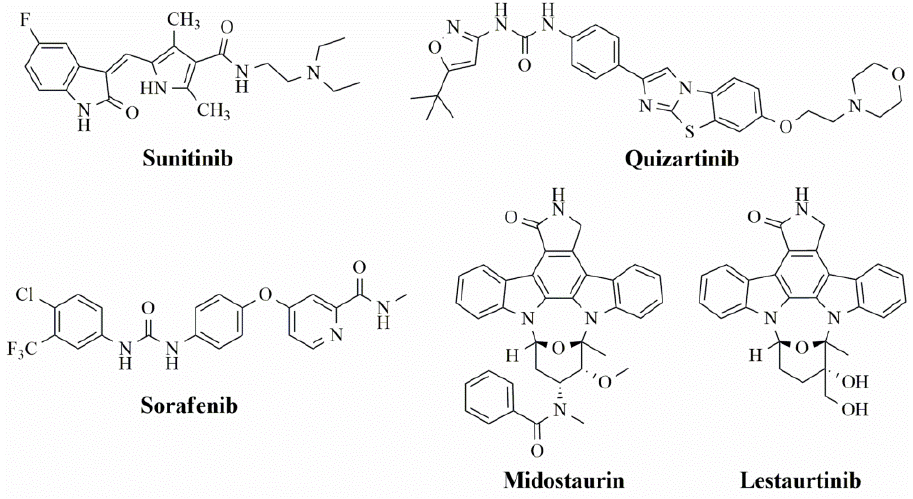
Figure 1 . Chemical structures of Sunitinib, Quizartinib, Sorafenib, Midostaurin, and Lestaurtinib. Figure 1. Chemical structures of Sunitinib, Quizartinib, Sorafenib, Midostaurin, and